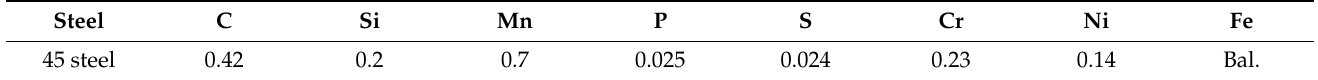
Table 1. Chemical composition of 45 steel (wt.%).